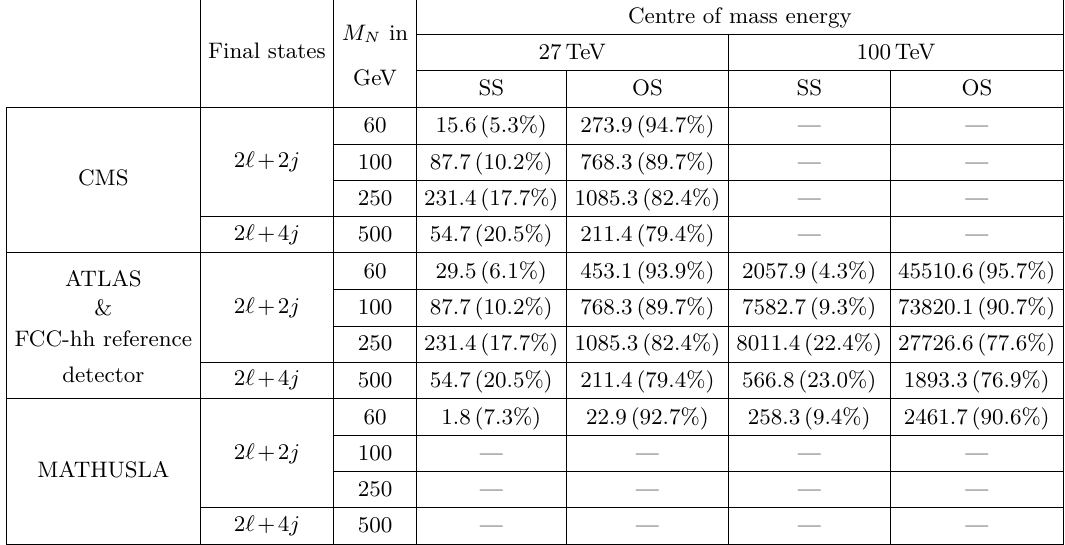
Centre of mass energy